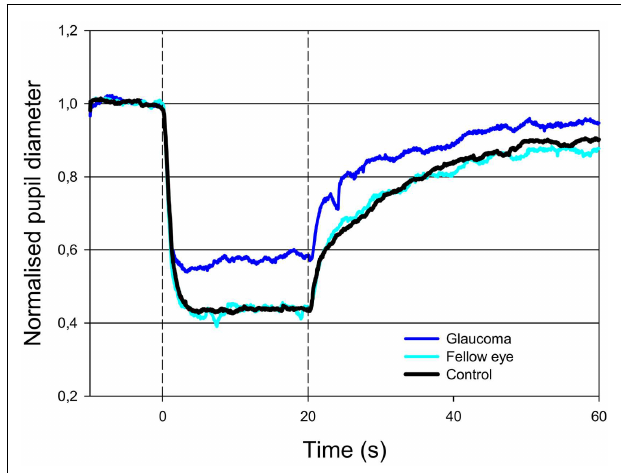
FIGURE 2 | Pupillary contraction to a blue-light stimulus (470nm) as a function of time (s) .Time period, stimulus luminance, and size of input pupil as in Figure 1 .The light blue graph represents pupillary contraction set off by stimulation of the unafflicted fellow eyes, the dark blue graph that set off by stimulation of the glaucomatous eyes. In comparison with the graphs in Figure 1 , contraction is larger during light-on in both graphs, and post light stimulus redilatation is far slower than that due to red light. Proportionally, the difference in contraction between the glaucomatous eyes (dark blue graph) and the unafflicted eyes (light blue graph) during blue light-on is equal to that detected in the red graphs (cf. Table 2 ). After light termination, the difference between the two blue graphs is slightly smaller than during light-on. Results represent mean values from 11 subjects suffering from unilateral glaucoma and the black graph the mean from 11 healthy control eyes.